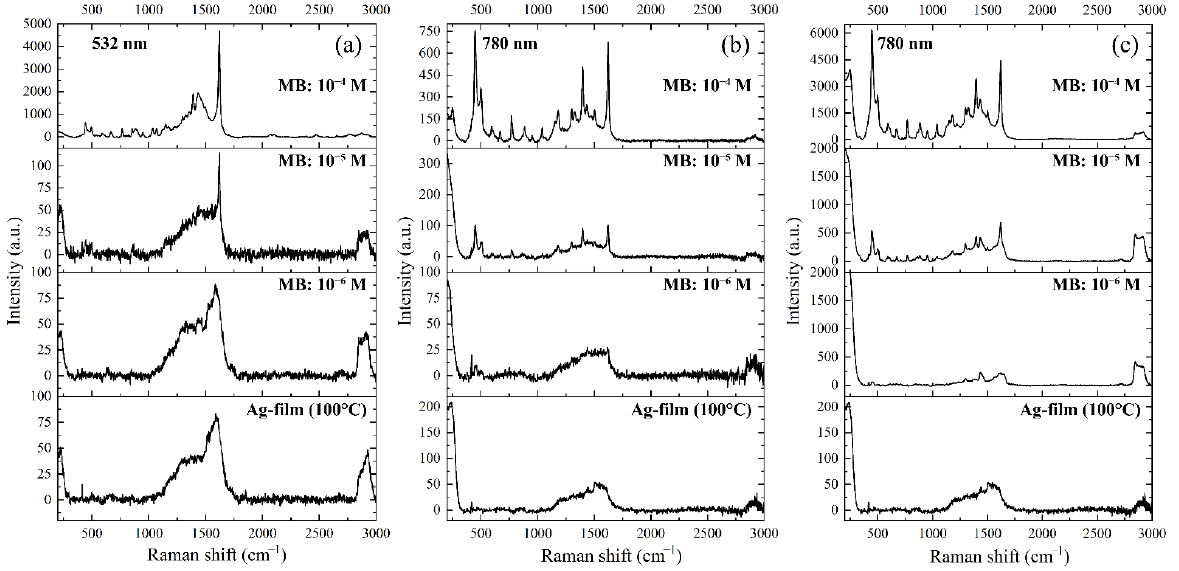
Figure 10. Raman spectra of Ag film (synthesis temperature—100 °C, additional heat treatment— 100 °C) and SERS spectra of methylene blue deposited on its surface at different concentrations recorded from the main surface ( a , b ) and from the dark region of Ag film ( c ) using lasers with wavelengths of 532 and 780 nm.